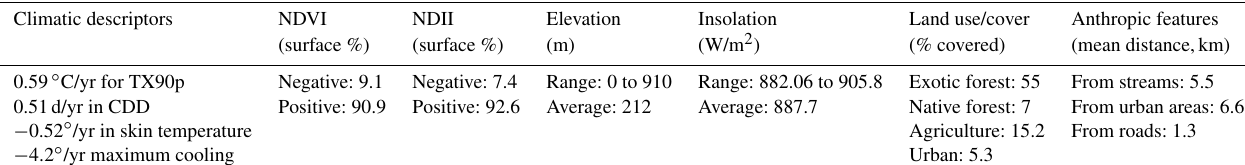
Table 2. Summary of the geodatabase components.